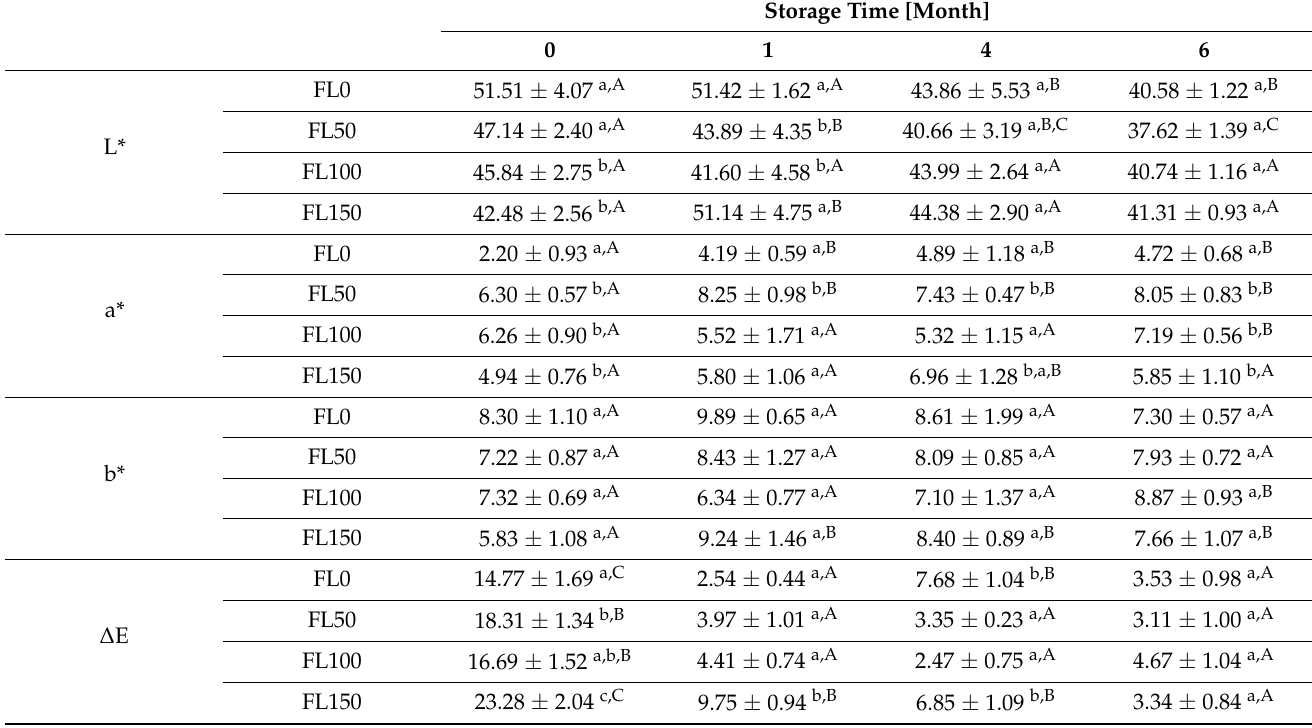
Table 6. CIE L* a* b* color parameters of fermented loins during storage (mean ± standard